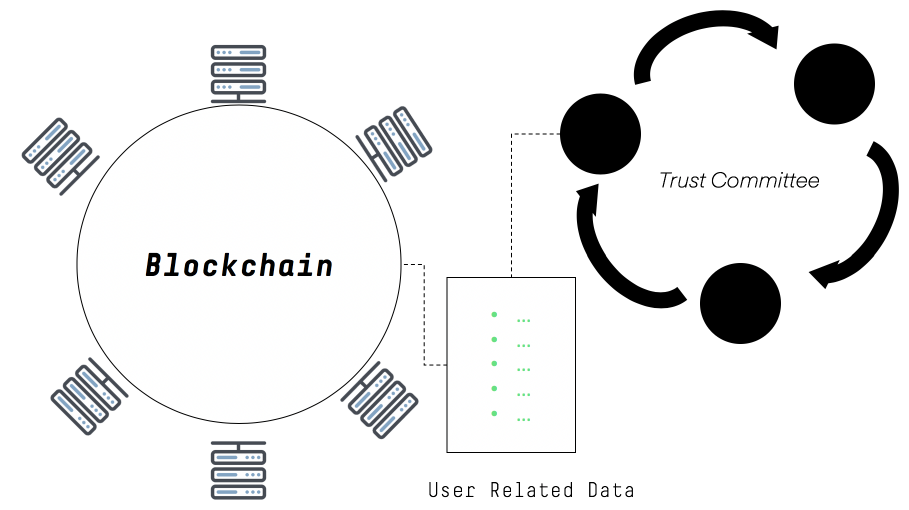
Figure 2. The trust committee takes user-related data from the Blockchain and commits an estimation of the user’s trust